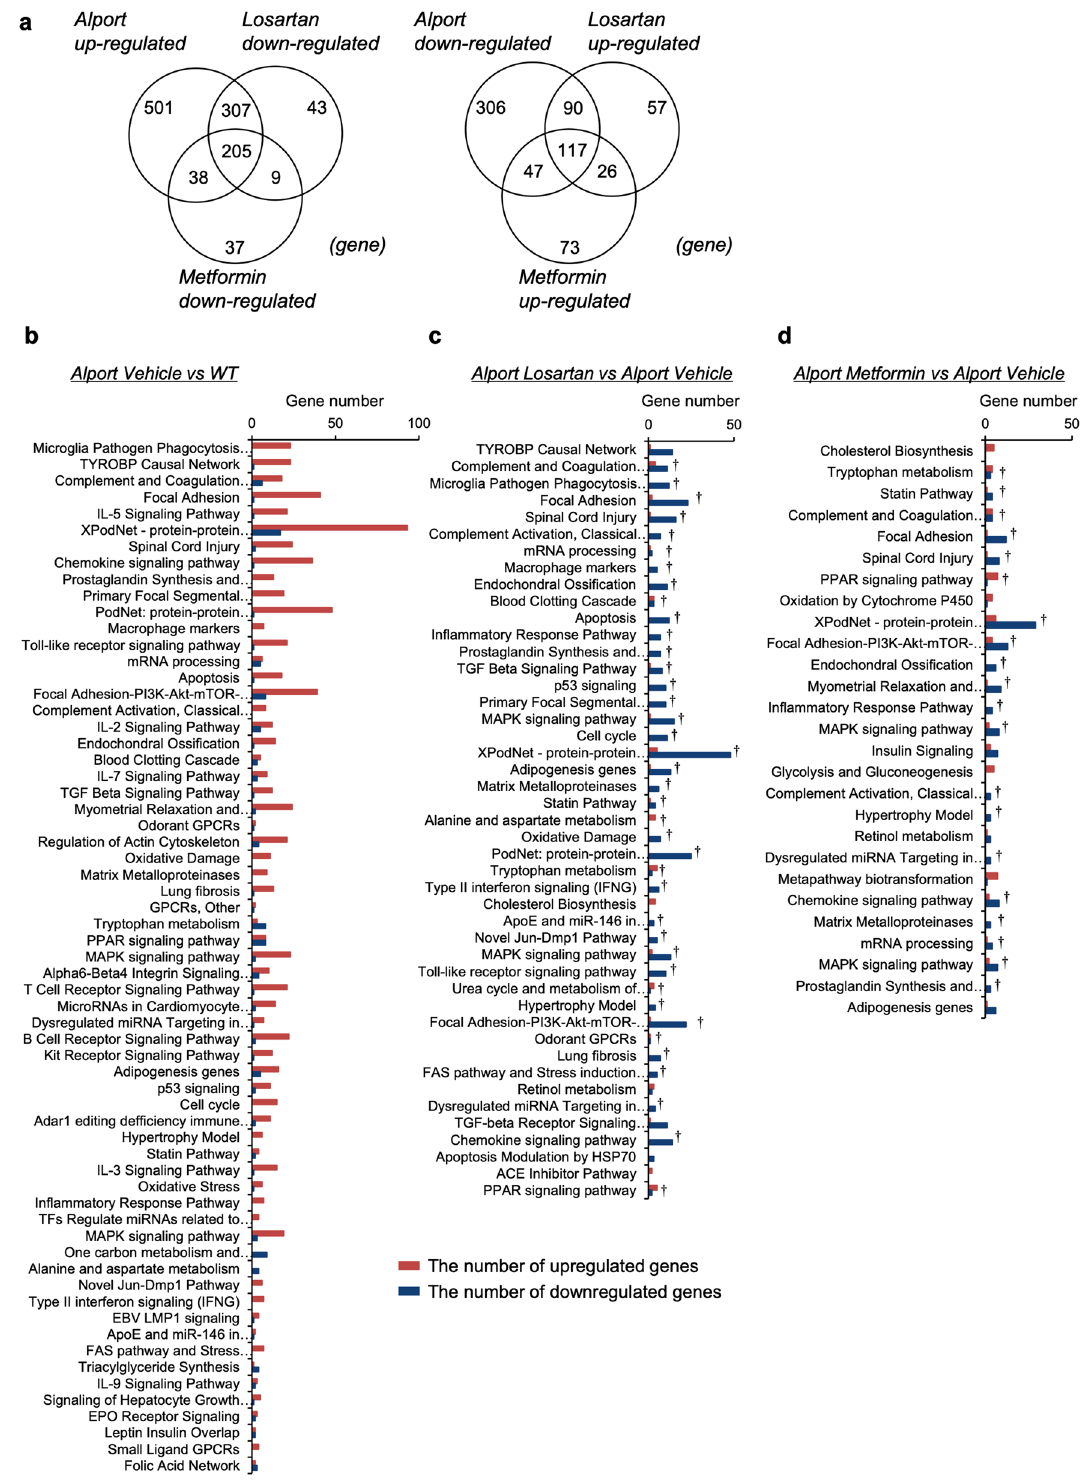
Figure 4. Transcriptome analysis reveals the comprehensive effects of metformin in kidney of Col4a5 G5X Alport syndrome mice. ( a ) Venn diagram shows the number of fluctuated genes in three comparisons (WT vs Alport vehicle, Alport vehicle vs Alport metformin, Alport vehicle vs Alport losartan). ( b – d ) Pathway analysis of fluctuated genes in Alport vehicle ( b ), Alport losartan ( c ), and Alport metformin ( d ). Red and blue bars represent the number of upregulated and downregulated genes, respectively. Pathways are displayed in ascending order of P value (P < 0.05). †: Common pathways between Alport/vehicle vs Alport/ losartan + metformin